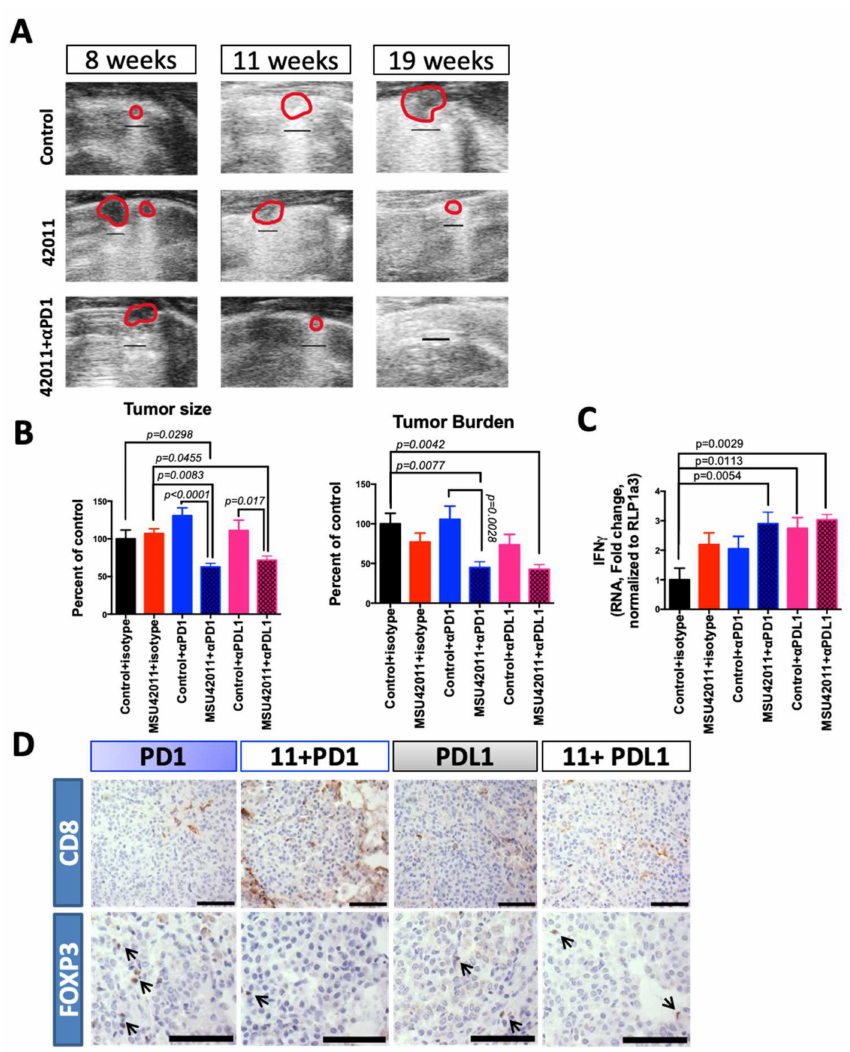
Figure 7. Combination of MSU42011 and anti-PD1 antibodies decreases tumor burden and increases anti-tumor T cells in the AJ model of lung cancer. ( A ) Ultrasound imaging of lung tumor growth over time in A/J mice challenged with vinyl carbamate to induce lung tumorigenesis in mice receiving only control diet, diet with MSU42011 (100 mg/kg) or MSU42011 and anti-PD1 antibody. ( B ) Graphical representation of Table 2 for tumor burden and size of A/J mice treated with MSU42011 (100 mg/kg- diet) plus anti-PD1 or anti-PDL1 antibodies. Mice were started on diet 8 weeks after vinyl carbamate injection, and anti-PD1, anti-PDL1 or isotype control antibodies were started 2 weeks after diet was started and given twice weekly (50 µ g/mouse) for a total of 22 administrations. ( C ) RT-PCR analysis of whole lungs of A/J after treatment, for levels of IFN γ ( n = 5). ( D ) Immunohistochemistry for CD8 and FOXP3 of lung tumors in A/J mice treated with anti-PD1 or anti-PDL1 antibodies in combination with MSU42011 (11). (scale bar 30 µ